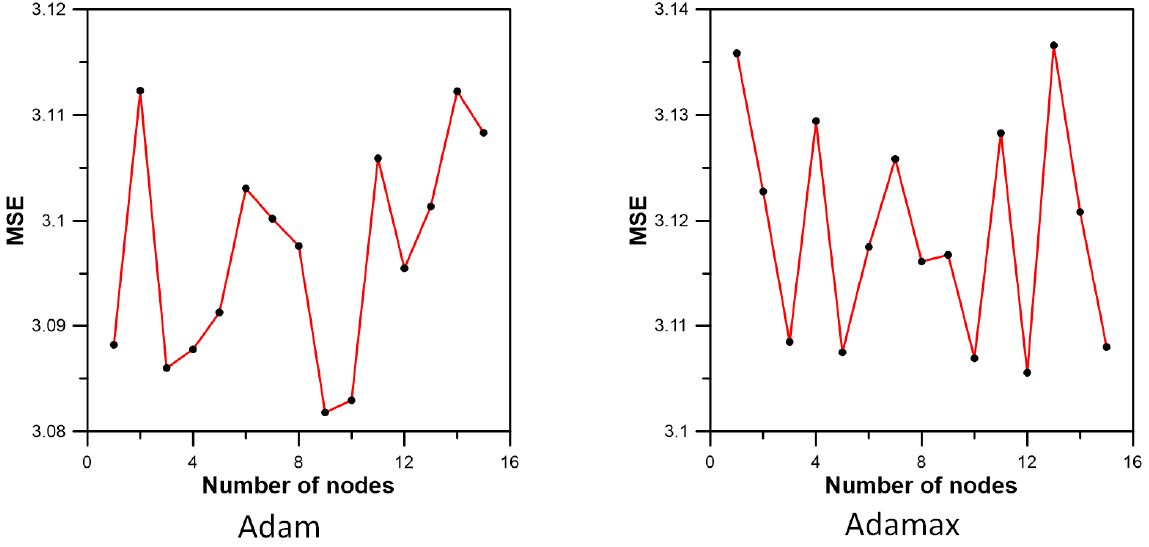
Figure 12. Results according to the number of nodes (Adam and Adamax).